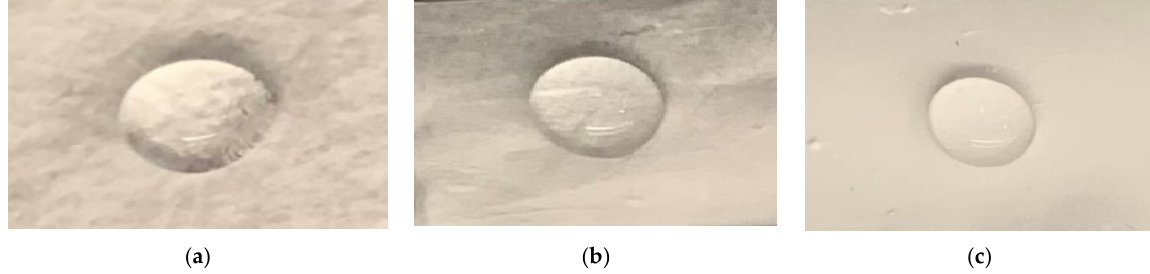
Figure 3. The architecture of 100 µL water droplet after 5 min on ( a ) control, ( b ) 3 min electrospun, and ( c ) 10 min electrospun cloth used during water absorption analysis.